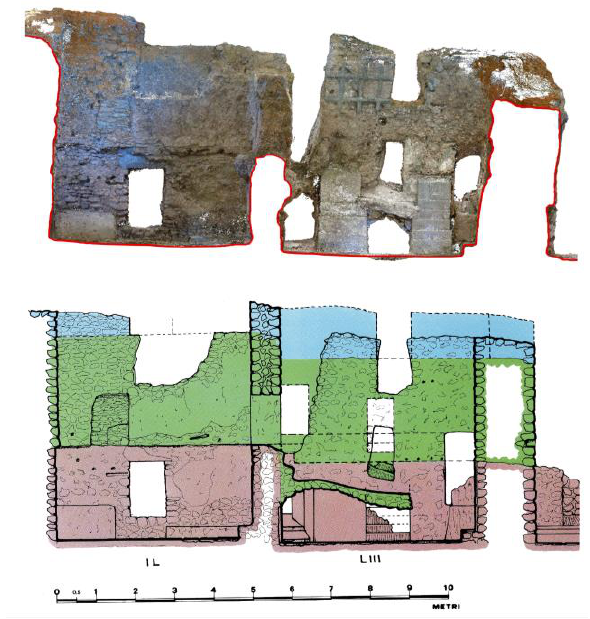
Figure 11. Detail of the section